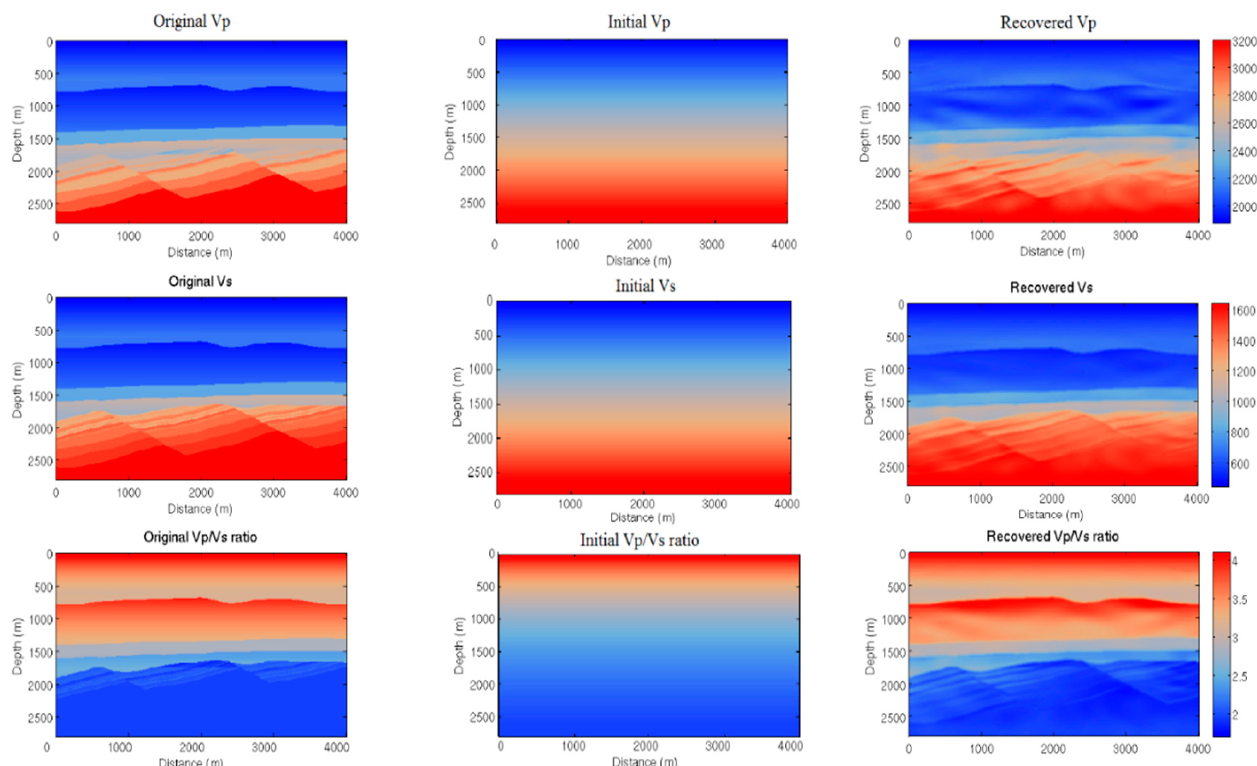
Figure 8. Gullfaks South elastic synthetic model. From left to right: original parameter, initial guess and inverted parameter using DSR FWI formulation. From top to bottom: Vp , Vs and the corresponding Vp / Vs ratio.